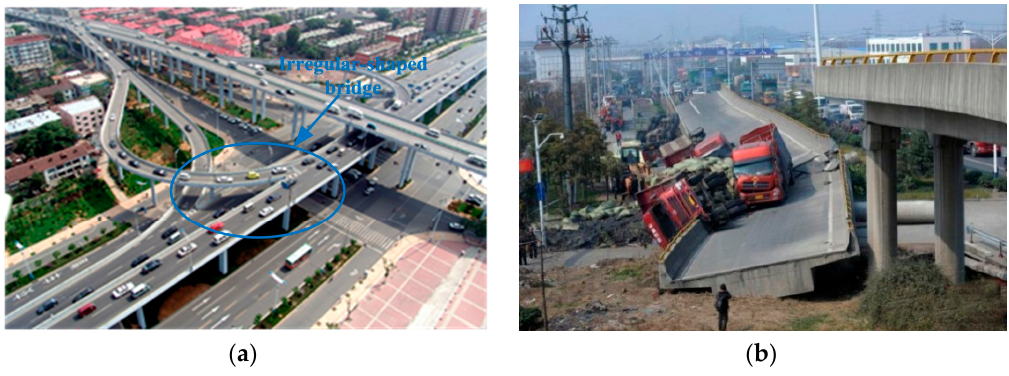
Figure 1. Irregularly-shaped bridge. ( a ) Plan view; and ( b ) collapse accident.